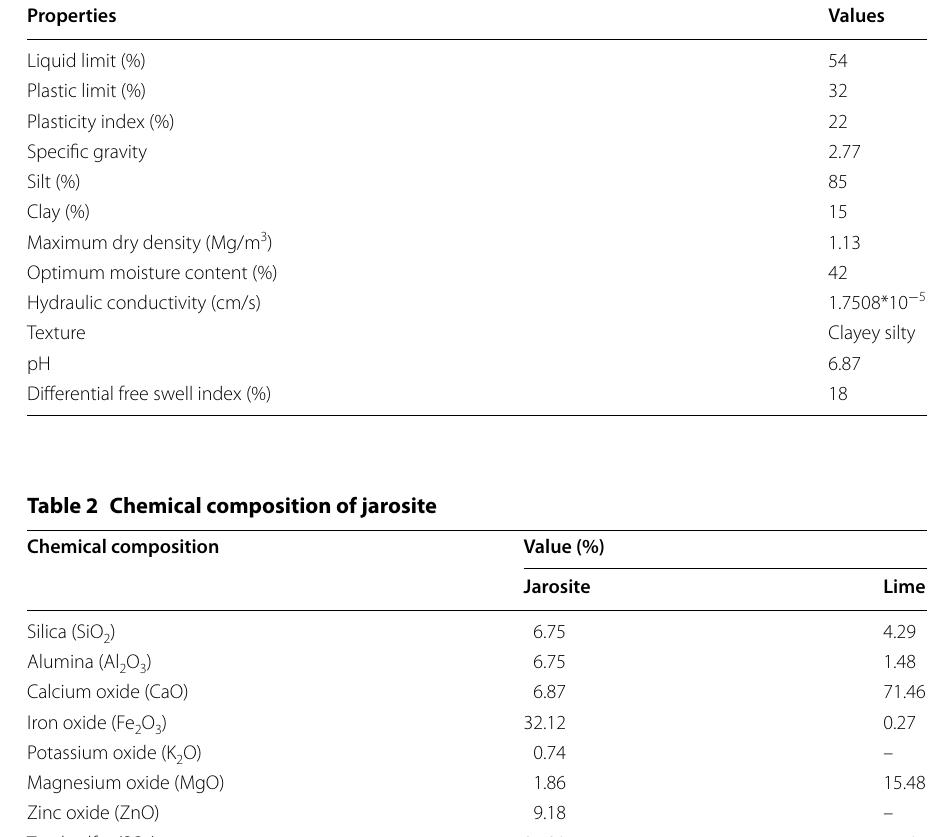
Table 1 Index properties of jarosite